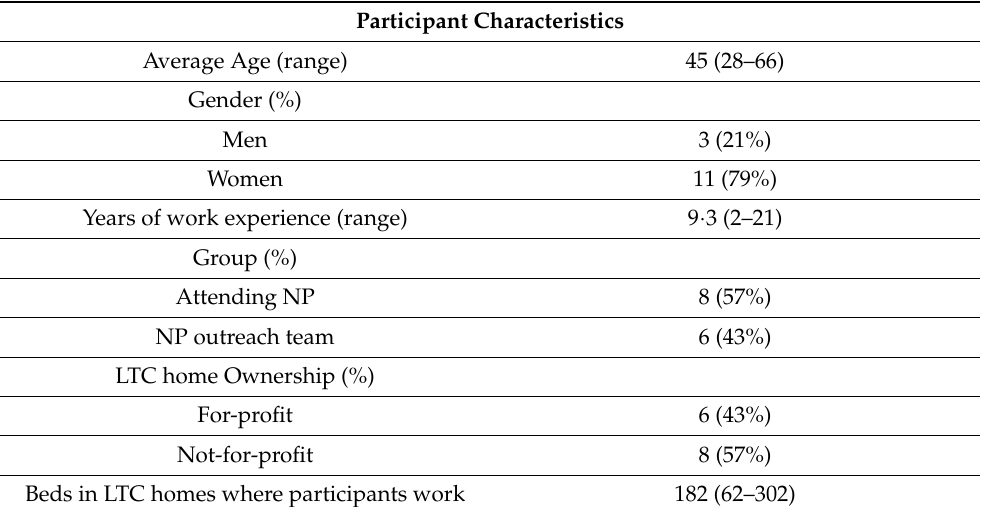
Table 1. Characteristics of study participants and their